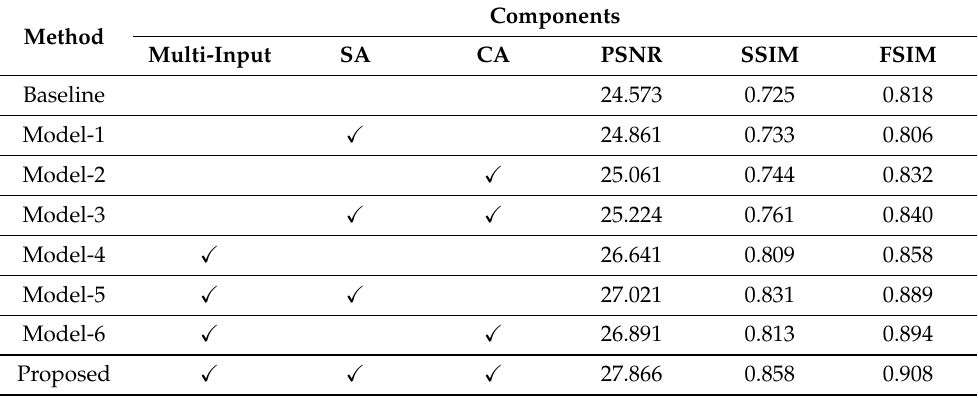
Table 8. Experimental results of different structural